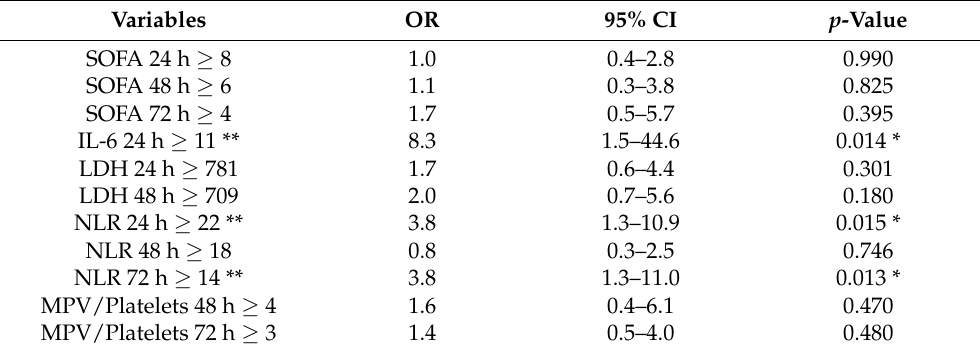
Table 4. Multivariate regression model to predict mortality at 28 days in patients with severe COVID- 19 admitted to the intensive care unit. * Mortality predictor variable, p < 0.05; ** significant risk CI does not include the value 1. MPV = mean platelet volume; NLR = neutrophil/lymphocyte ratio; CI = confidence interval; OR = odds